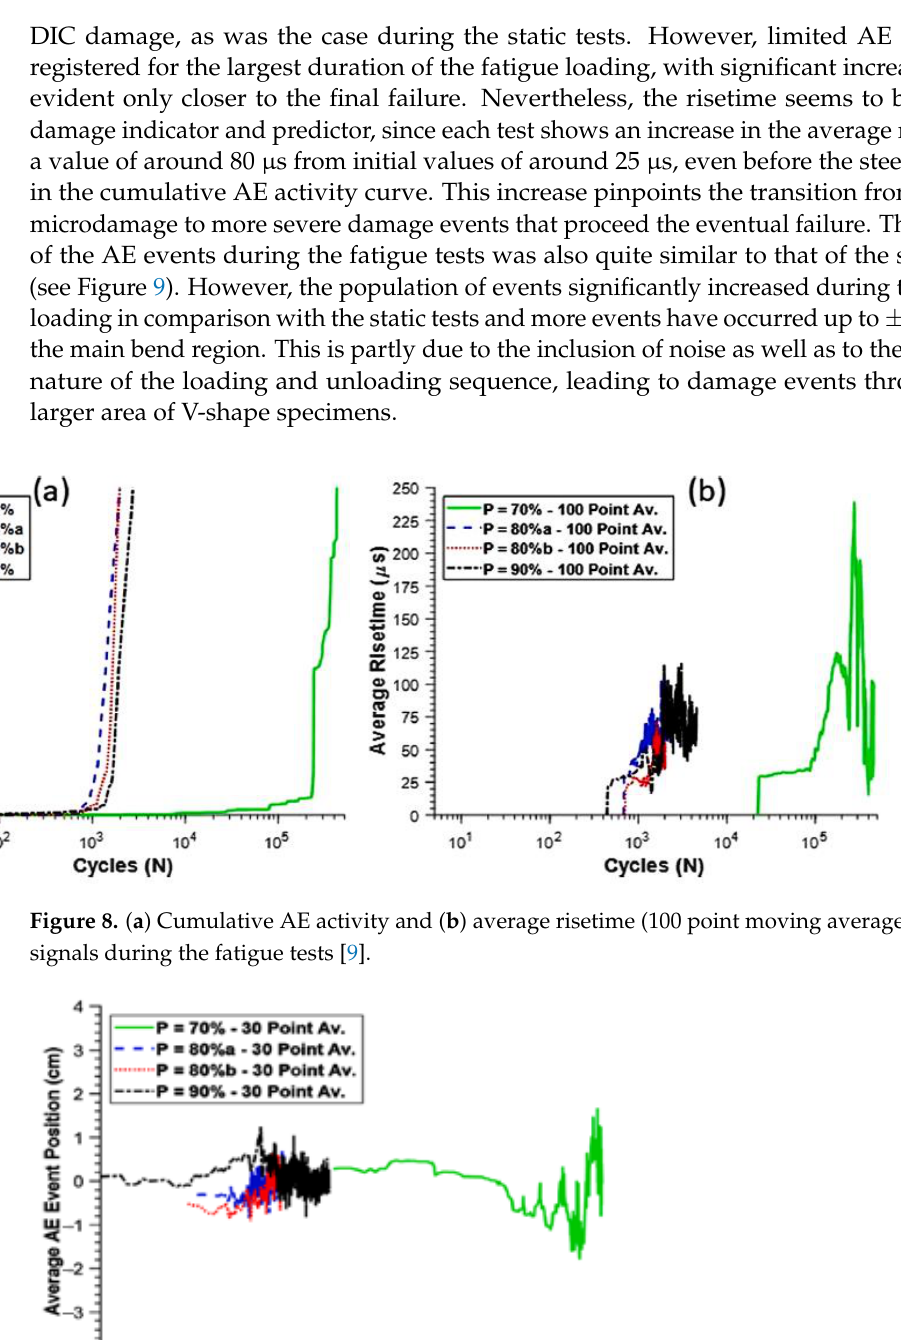
Figure 7. DIC strains ( a ) ‘e xx ’ and ( b ) ‘e yy ’ for different load levels along line C – C in Figure 6 [9].